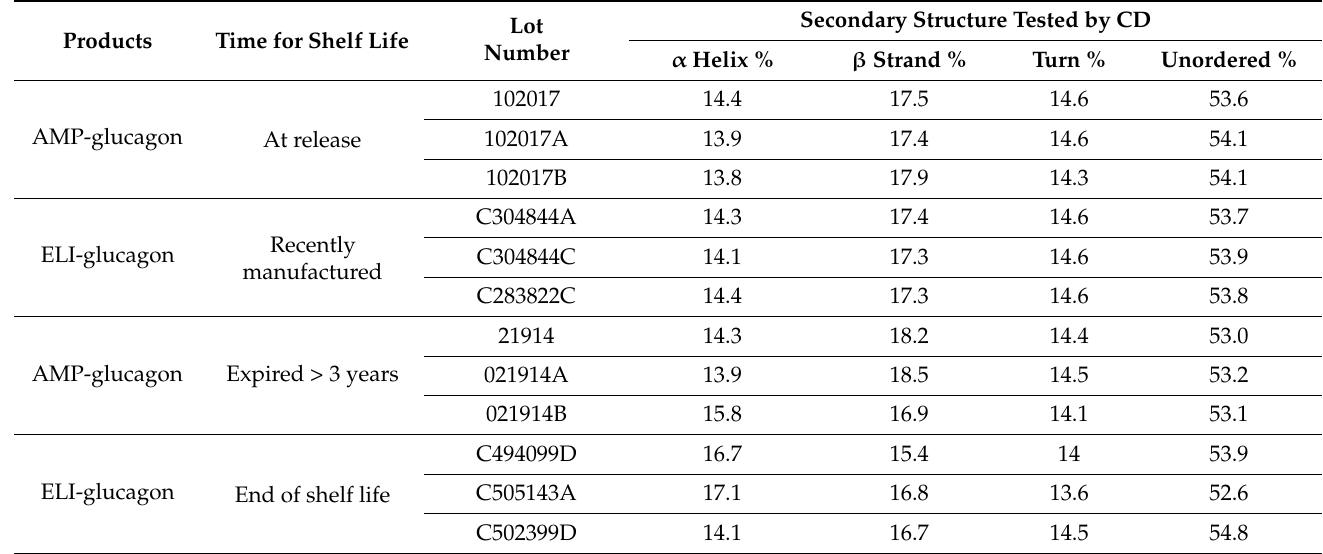
Table 1. Secondary Structure Content of AMP-Glucagon and ELI-Glucagon by CD.